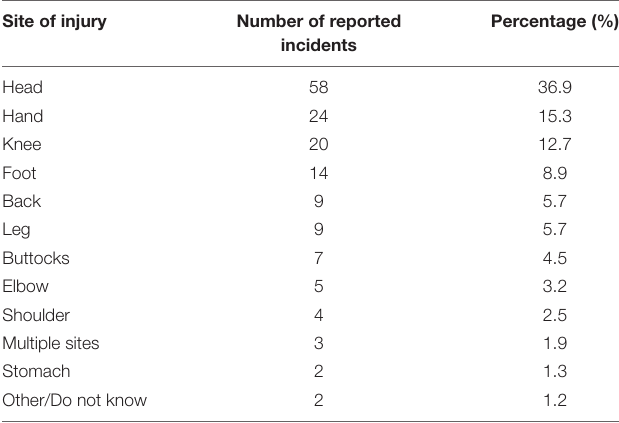
TABLE 2 | Breakdown of the reported sites of injury in “everyday” pain